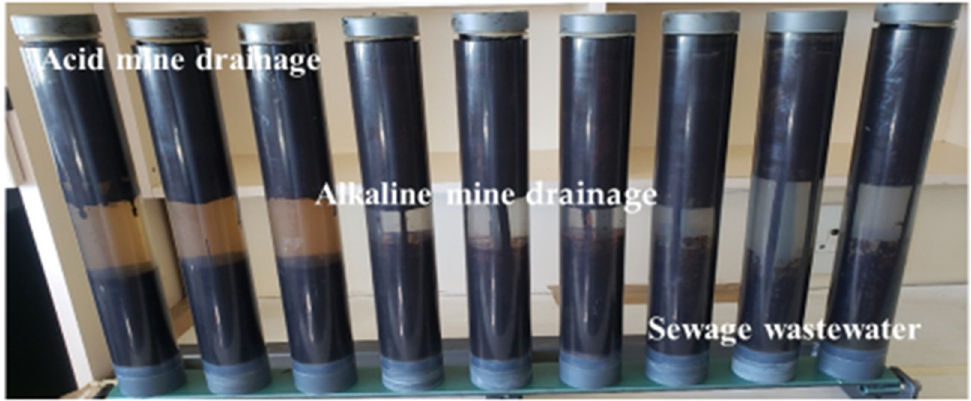
Figure 2. Leaching process of PAHs in acid mine drainage, alkaline mine drainage and sewage wastewater. Determination of PAHs from